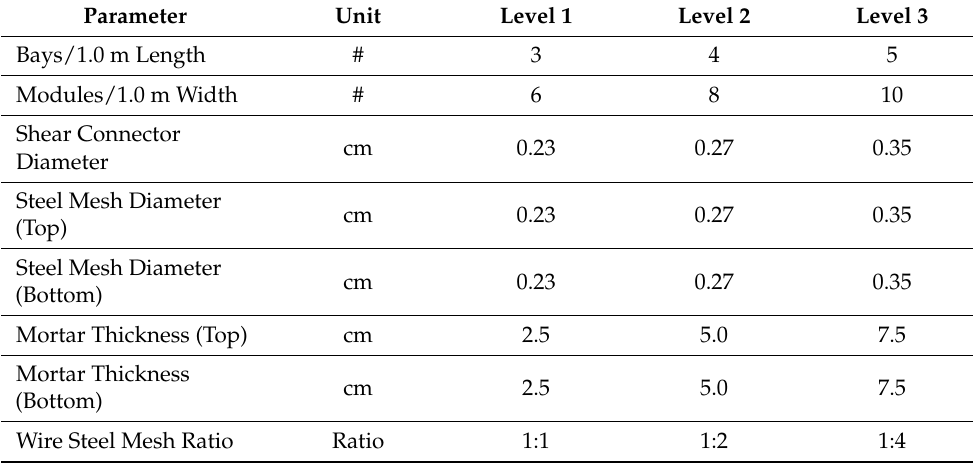
Figure 6. Boundary conditions of CSP with inclined shear transfer connectors. Table 2. Design variables for optimization of CSP